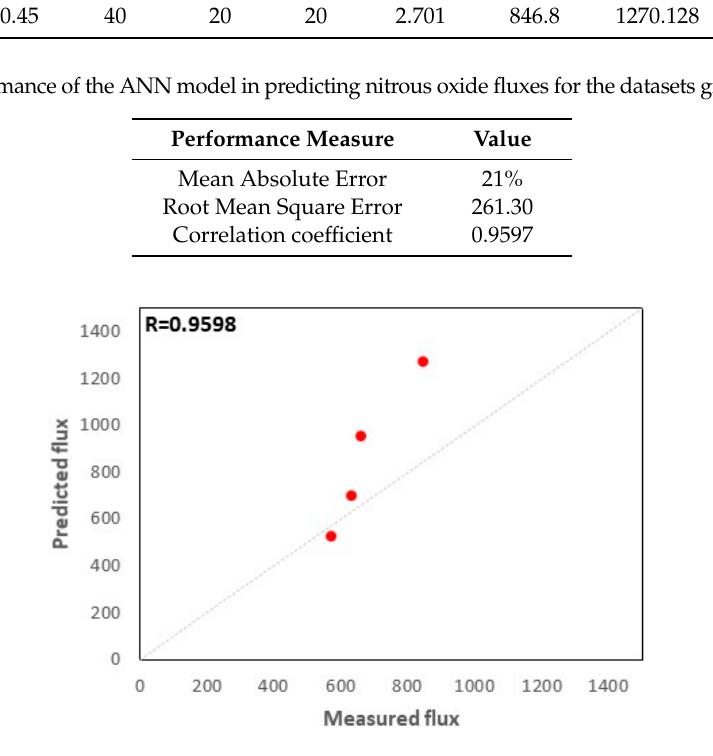
Figure 9. Performance of the ANN model in simulating the nitrous oxide emissions from the four independent datasets not used for training and testing of the model.